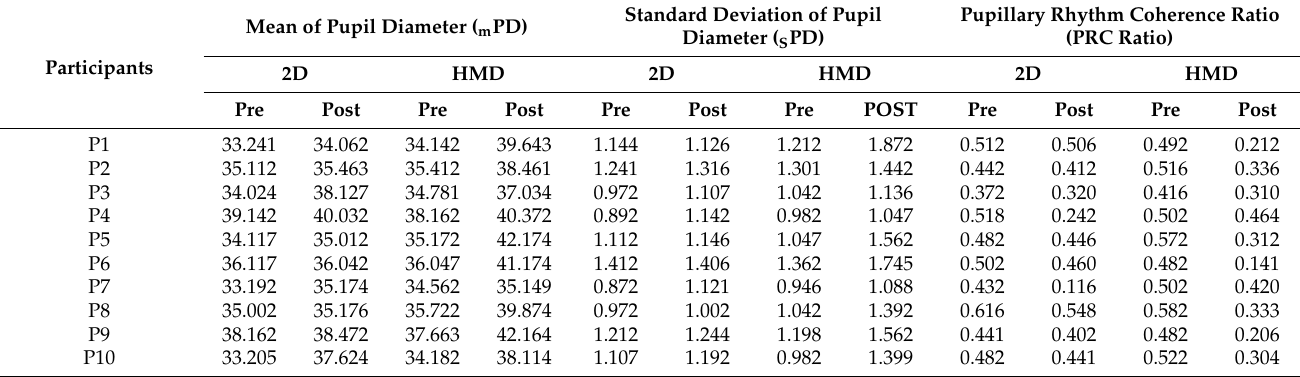
Table A2. Results of the validation experiments (test data set) for 23